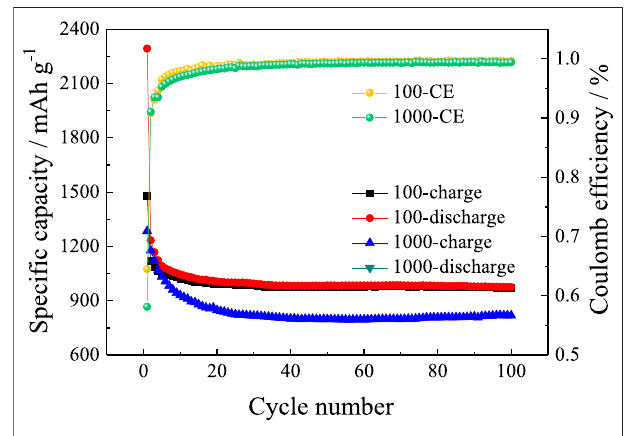
FIGURE 8 | Cycle performances of SnO 2 @C/graphene at different current